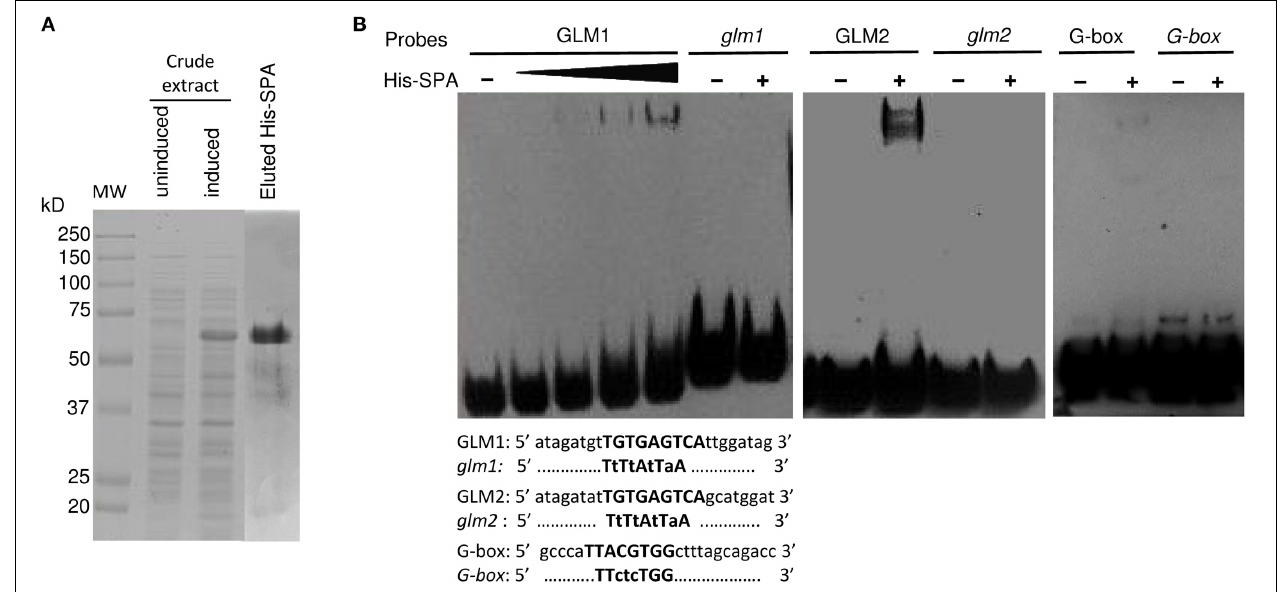
FIGURE 7 | Binding of recombinant SPA protein with the probes derived from the Glu-B1-1 gene promoter. (A) Expression and purification of recombinant His-SPA protein. Crude extracts from uninduced and induced bacteria harboring the pHis-SPA expression vector and the eluted protein were resolved on an SDS-polyacrylamide gel. The molecular mass markers are indicated at left in kilodaltons. (B) EMSA of the recombinant SPA protein